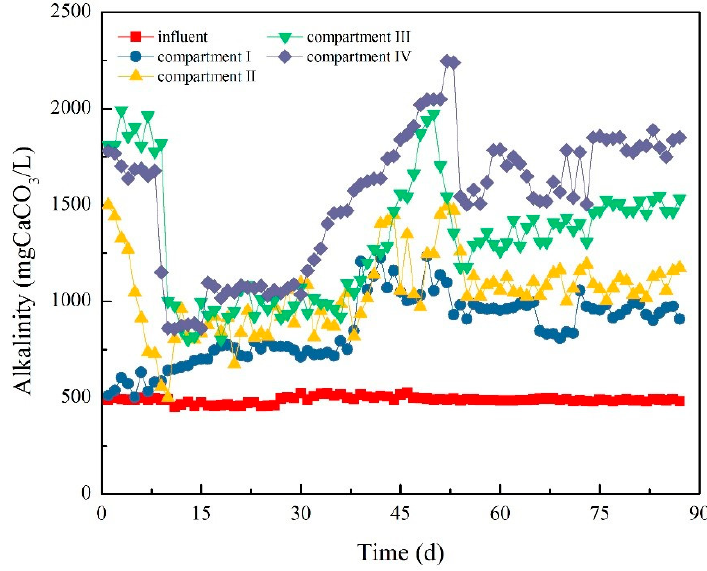
Figure 13. Variation of alkalinity in each compartment.